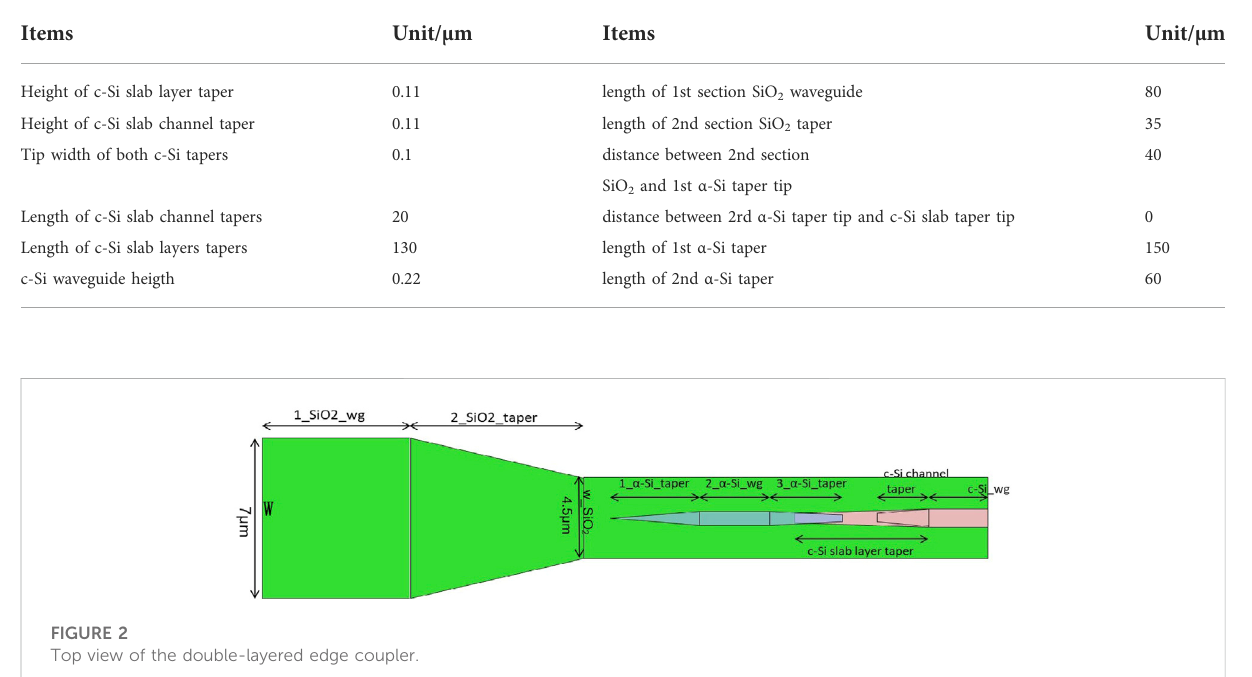
TABLE 1 Design parameters of the double-layer edge couple.